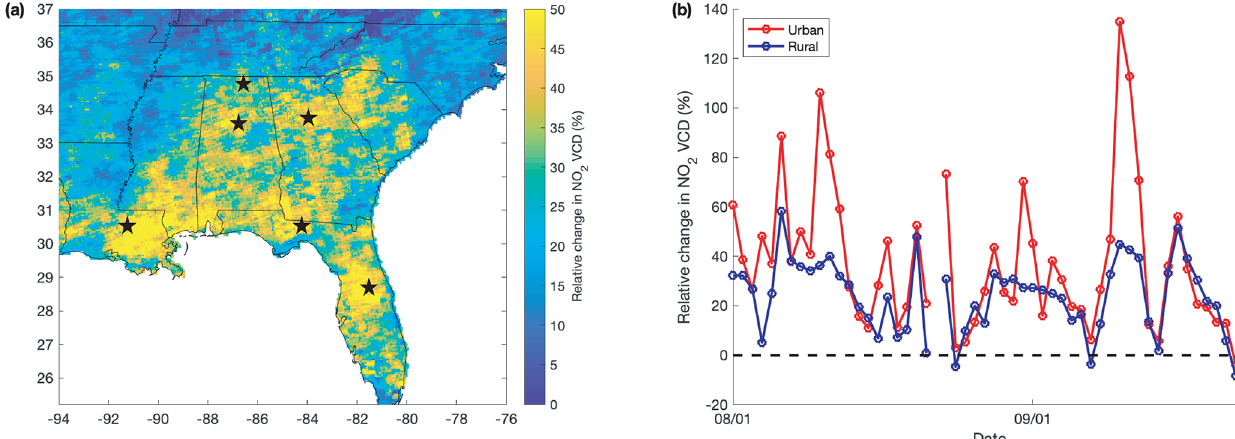
Figure 3. Relative change in BEHR NO 2 VCD over the southeastern US switching the source of a priori NO 2 profiles from WRF-Chem outputs using G3/CTH to one using the KF/CAPE-PR lightning parameterization. Panel (a) shows the mean spatial distribution of the changes from 1 August to 23 September 2013 and panel (b) shows the temporal variation over urban and rural areas. Only observations with a cloud fraction less than 20% are included. Medium to large cities are marked by stars in panel (a) : Atlanta, GA; Huntsville, AL; Birmingham, AL; Tallahassee, FL; Orlando, FL; and Baton Rouge,